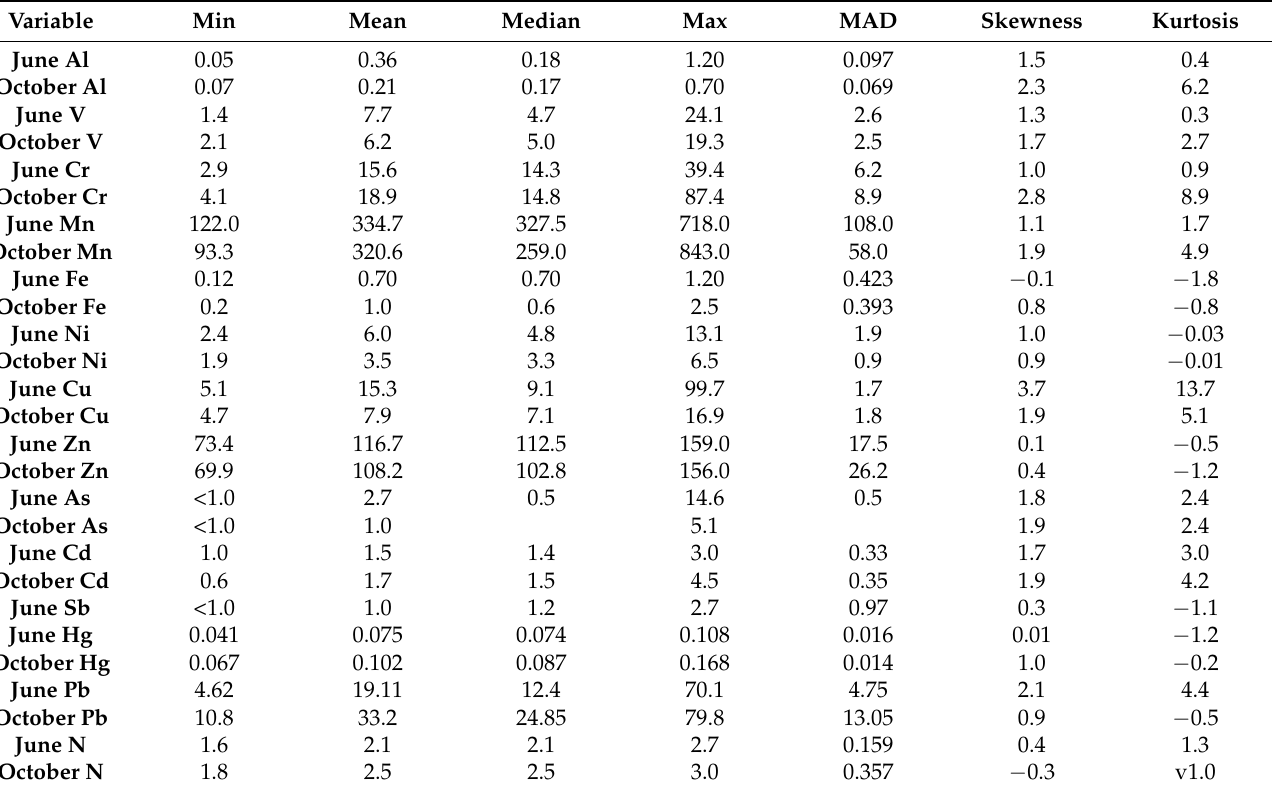
Table 1. Synoptic table of minimum (Min), maximum (Max) value, mean, median, median absolute deviation (MAD), skewness and kurtosis of elements content (ug · g − 1 ) and (wt.%) for Al, Fe and N.